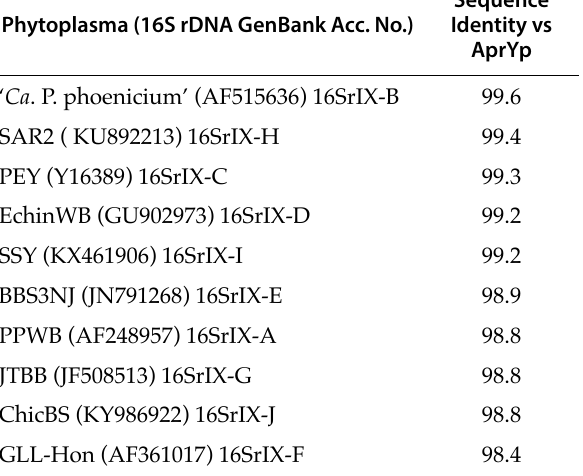
Table 2. 16S rDNA nucleotide sequence identity (%) of AprY phytoplasma versus 16SrIX group reference strains.